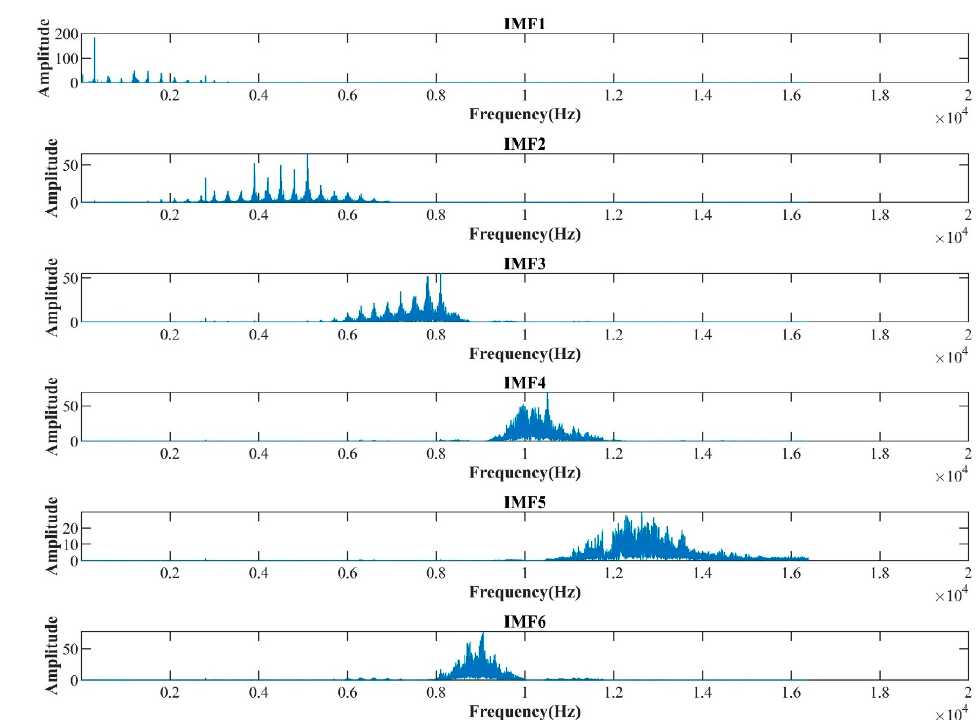
Figure 8. Frequency ‐ domain signal in the early failure period after VMD decomposition. Figure 8. Frequency-domain signal in the early failure period after VMD decomposition.